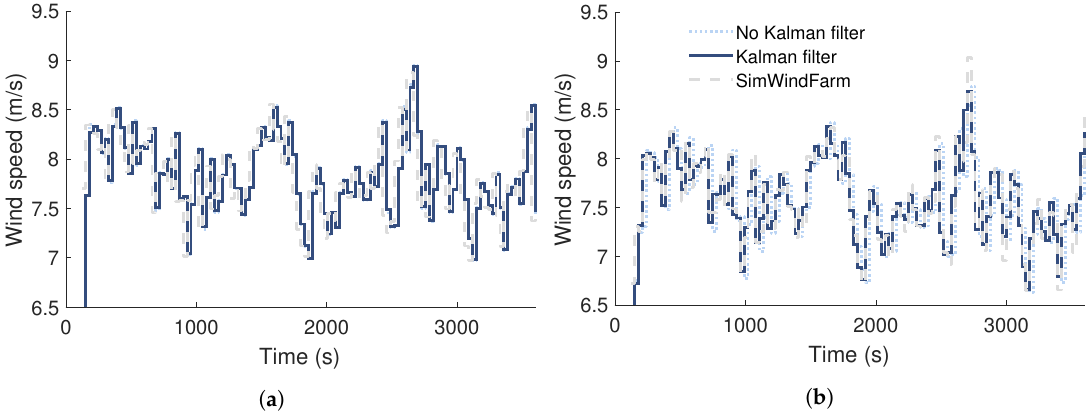
Figure 4. Sampled rotor effective wind speed simulated using SWF and predicted using DFP with and without use of Kalman filter. Shown are wind speeds of ( a ) turbine No. 1 and ( b ) turbine No.